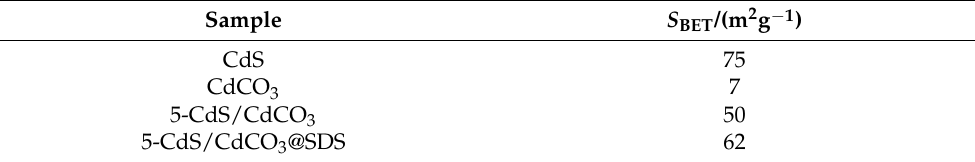
Table 1. Surface areas ( S BET ) of CdS, CdCO 3 , 5-CdS/CdCO 3 and 5-CdS/CdCO 3